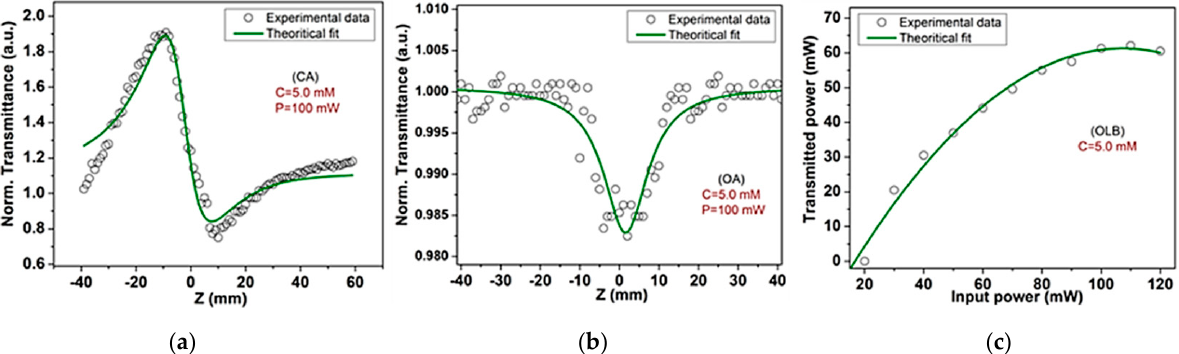
Figure 9. Normalized transmittance traces for ( a ) close aperture (CA) and ( b ) open aperture (OA), ( c ) optical limiting behavior (OLB).